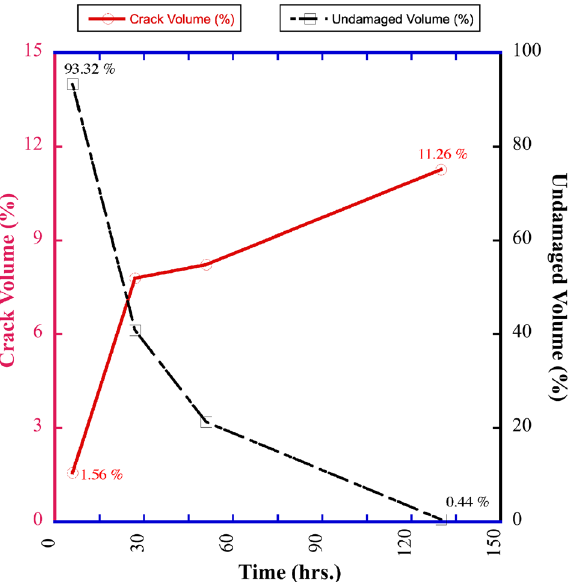
Figure 5. The total crack percent volume (left y-axis) and percent volume of the undamaged zones (right y-axis) in a CB-SK10 geo-architected sample that was monitored for > 130 h of moisture loss with a Zeiss Xradia 3D X-ray Microscope at ambient relative humidity and an average system temperature of 28 °C. The data obtained show that an increase in the volume and distribution of cracks naturally results in a reduction of the zones within the structure where no damage has occurred. Here the solid line relates to the left y-axis and the dashed line is associated with the right